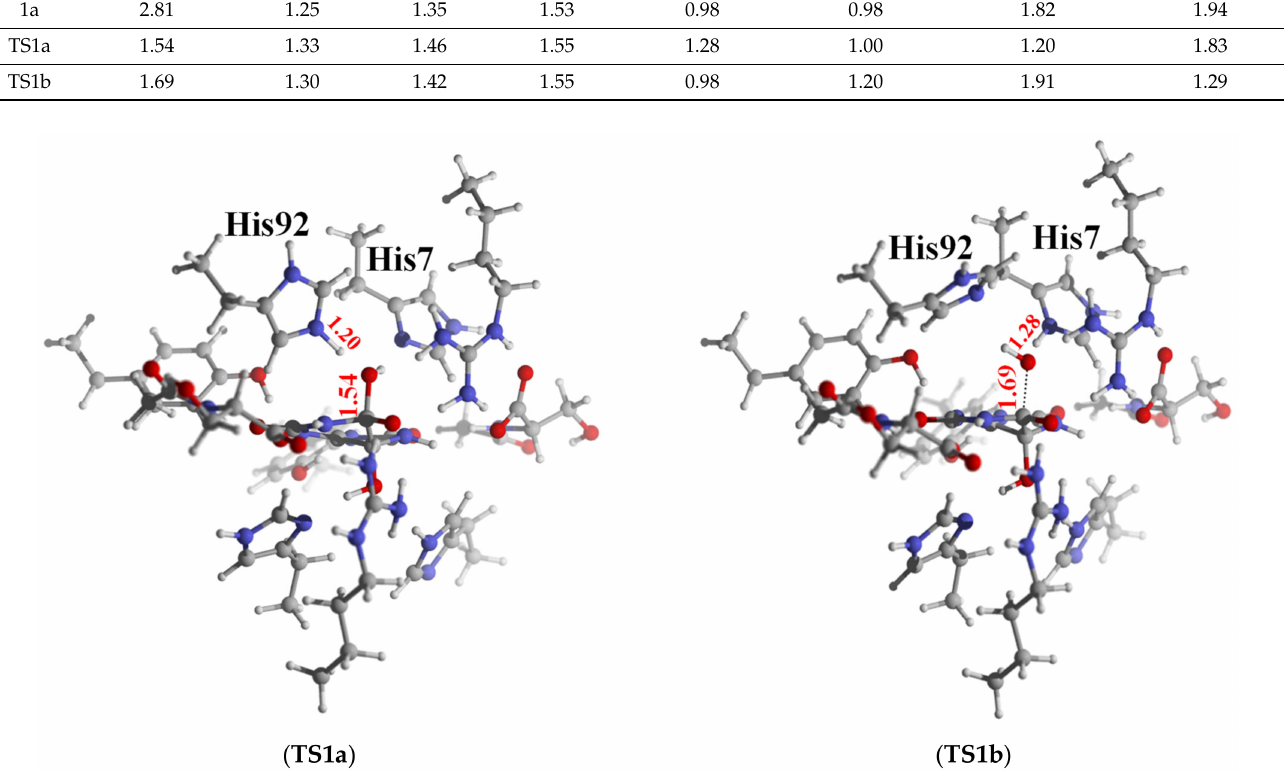
Figure 7. The geometry structure of TS1a and TS1b ; some important bond lengths are labeled in the unit of Å. Although the two transition states are quite different in their geometry structures, the intermediates in two reaction pathways ( Int1a and Int1b ) are very similar. The two intermediates are also very close in their energy with Int1a slightly lower by 1.0 kcal/mol. In both Int1a and Int1b , C6 presents a tetrahedral conformation with C6–N1 bond stretch- ing to 1.46 Å. The C6 carbonyl bond converts to a C–O − single bond, with bond length of 1.33 Å. The calculated Mulliken charge population on the O − is − 0.72 in Int1a and − 0.74 in Int1b . C6=O group keeps the four hydrogen bond interactions with two Arg41 from two protein chains in these two intermediates. The corresponding hydrogen bond lengths are listed in Table